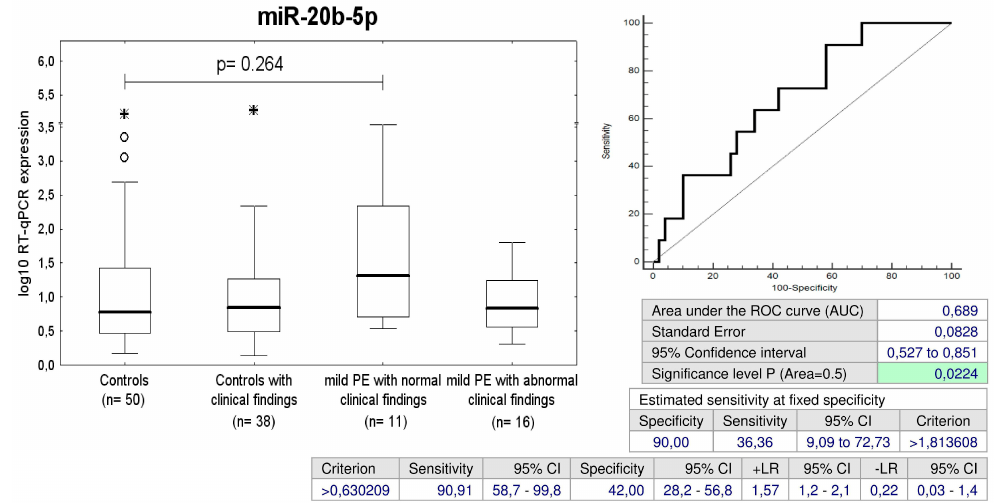
Figure 14. Increased expression of miR-20b-5p in children with normal postnatal clinical findings descending from mild PE pregnancies.